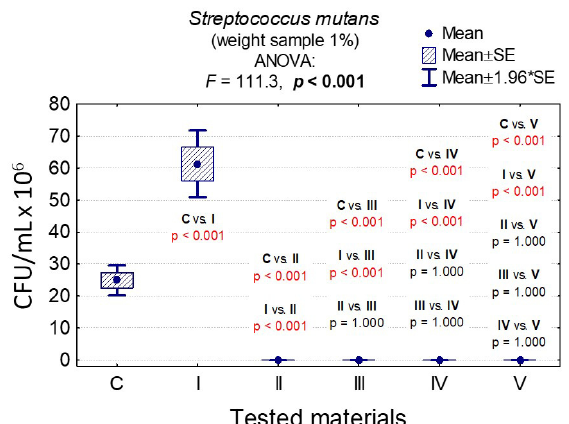
Figure 12. Average CFU/mL values and standard deviation (M ± SD) for Streptococcus mutans after temporary contact with the tested materials (C—growth control, I—nHAp, II—Cu 2+ -doped